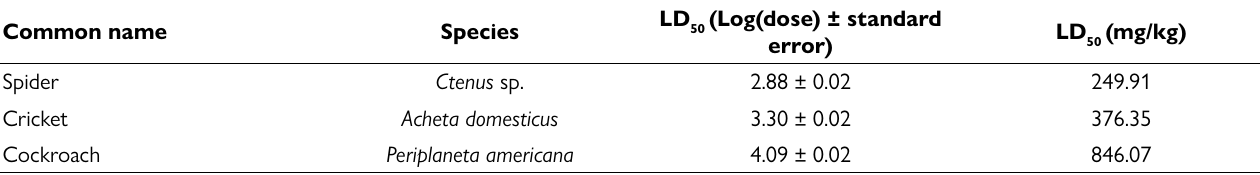
values for each prey type. 50